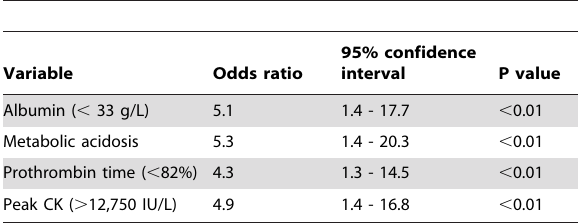
Table 3. Variables associated with AKI in patients with severe rhabdomyolysis. Results of logistic regression analysis.